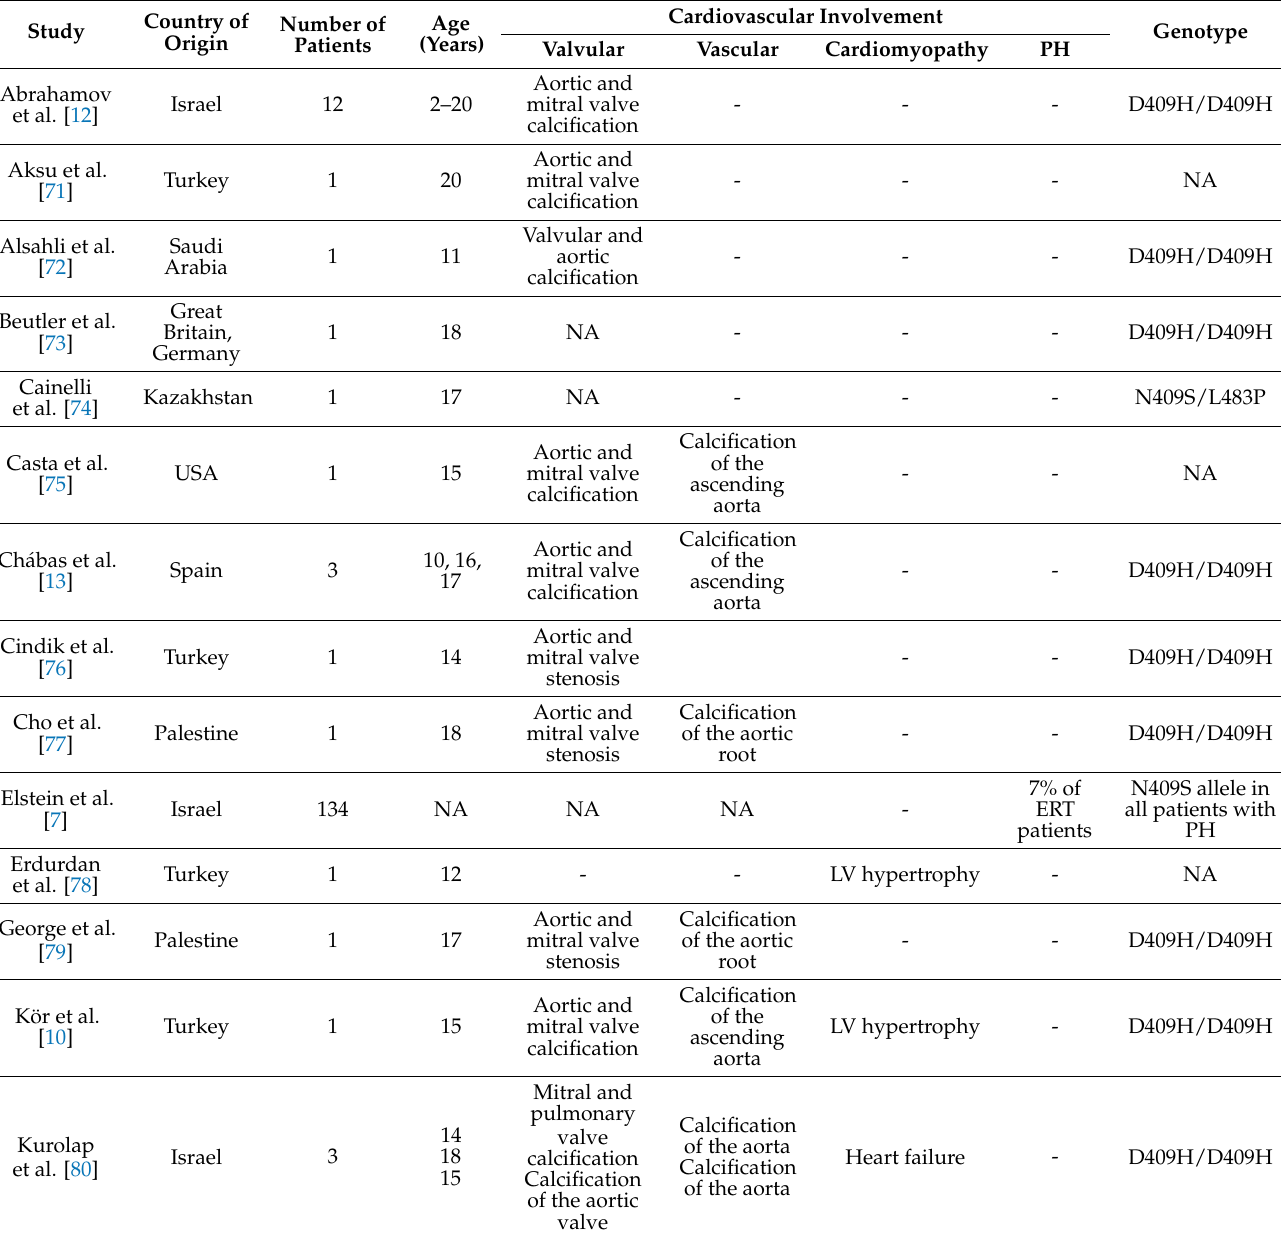
Table 7. Cardiovascular involvement in Gaucher